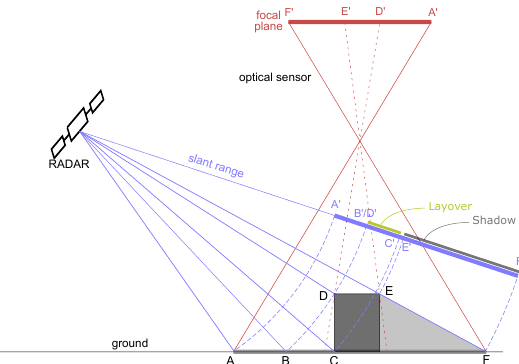
Figure 4. Schematic comparison between the SAR and optical imaging principles. While an optical system measures angles, a SAR converts signal travel times to distances and maps them into its resolution cells – and is inherently